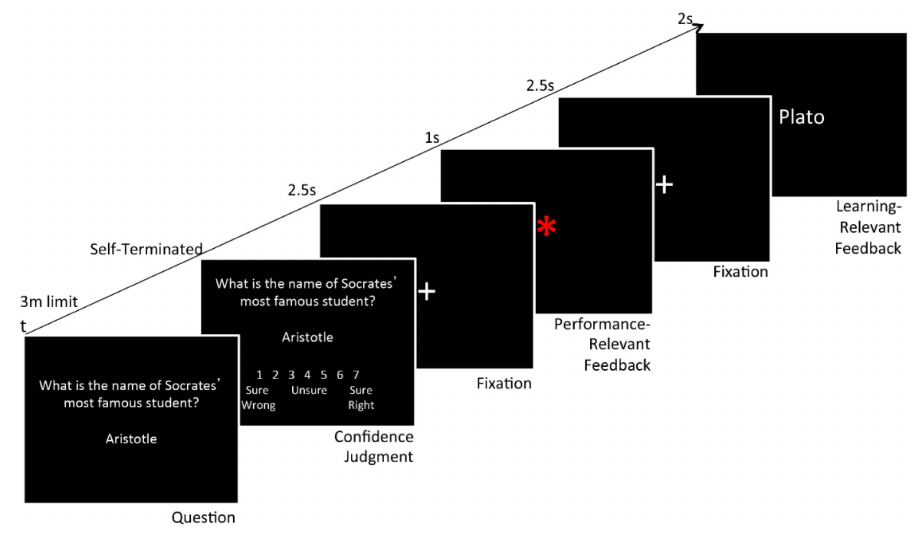
Figure 1. First-test trial structure. Example of a trial with an incorrect answer. If the answer had been correct, a green asterisk would have been